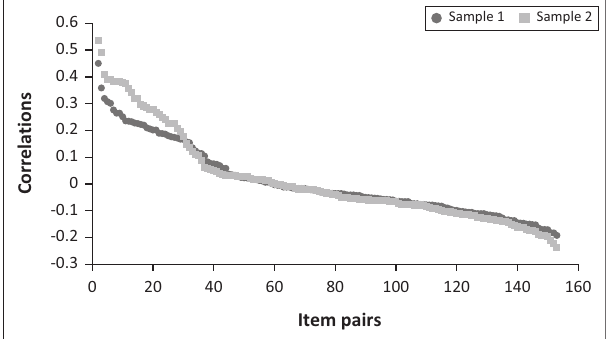
FIGURE 5: Ranked correlated residuals: 1-factor (Fact) model.